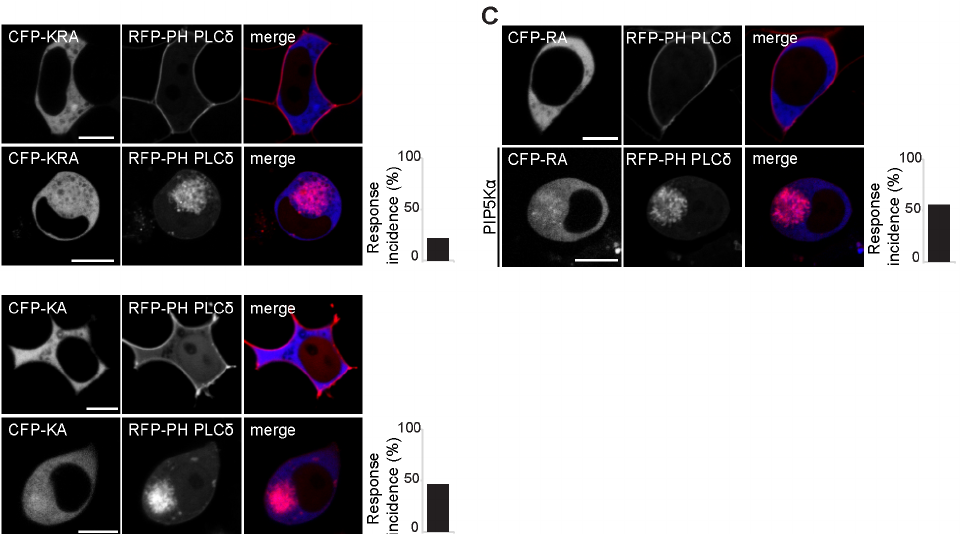
Figure 3. Positive residues within the PDZ domain are required for binding to PA. A. Mutation of lysine 428 and arginine 429 within the PDZ domain to a non-polar alanine (CFP-KRA) impairs interaction with PA on PIP5K a -generated vesicles in HEK293T cells. B, C. Substitution of either lysine 428 or arginine 429 alone with alanine (CFP-KA and CFP-RA respectively) results in impaired ability of the protein to associate with vesicular PA in HEK293T cells. The bar graphs show percentage of cells localized on PIP5K a -generated vesicles (3/11 cells for CFP-KRA, 5/11 cells for CFP-KA and 6/